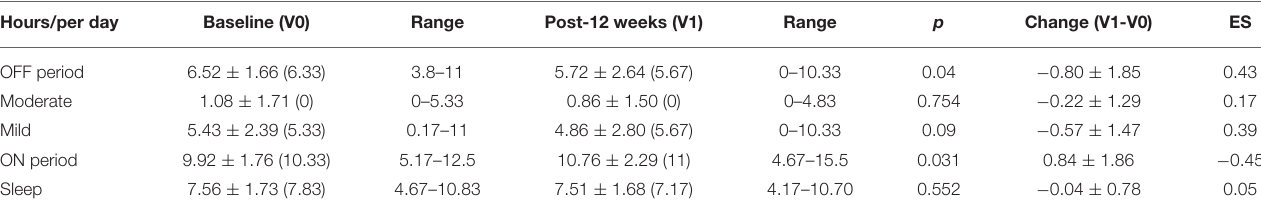
TABLE 3 | Diary recordings of ON and OFF durations in patients with PD at baseline and after 12 weeks of intervention. Hours/per day